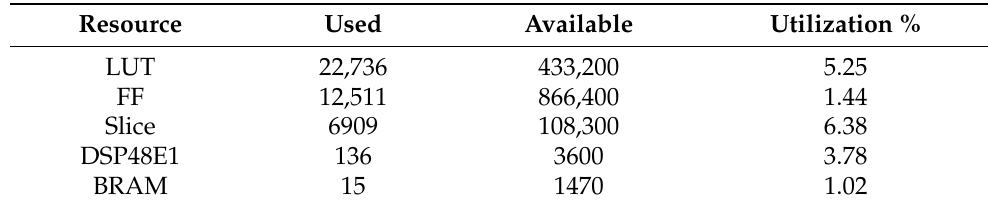
Table 3. Resource consumption of proposed generic ECC architecture on Virtex-7 field-programmable gate array